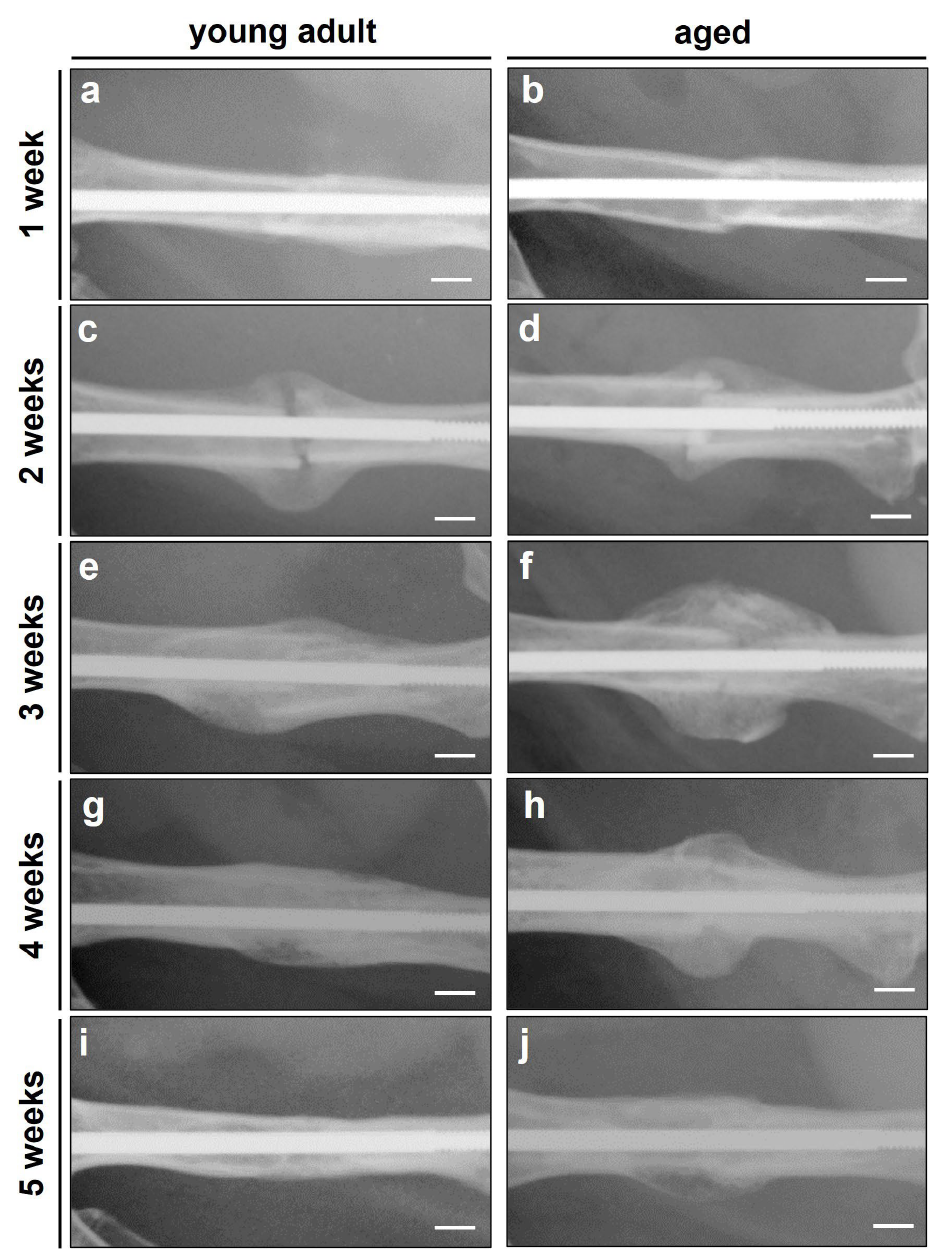
Figure 2. ( a – j ) Representative X-rays of fractured femora at 1 ( a , b ), 2 ( c , d ), 3 ( e , f ), 4 ( g , h ) and 5 weeks ( i , j ) after fracture in young adult ( a , c , e , g , i ) and aged ( b , d , f , h , j ) CD-1 mice. Scale bars: 1 mm.